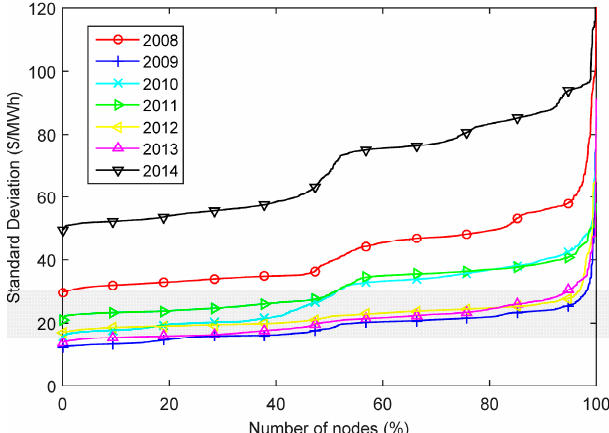
Figure 5. Annual standard deviation of real-time prices in PJM, encompassing 7395 nodes. The values are independently sorted by year.